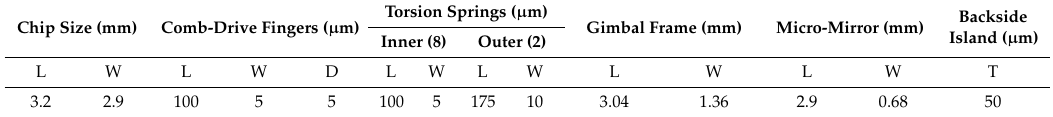
Table 1. Structural features of the 2D resonant MEMS scanner. L, length; W, width; D, distance (gap); T,